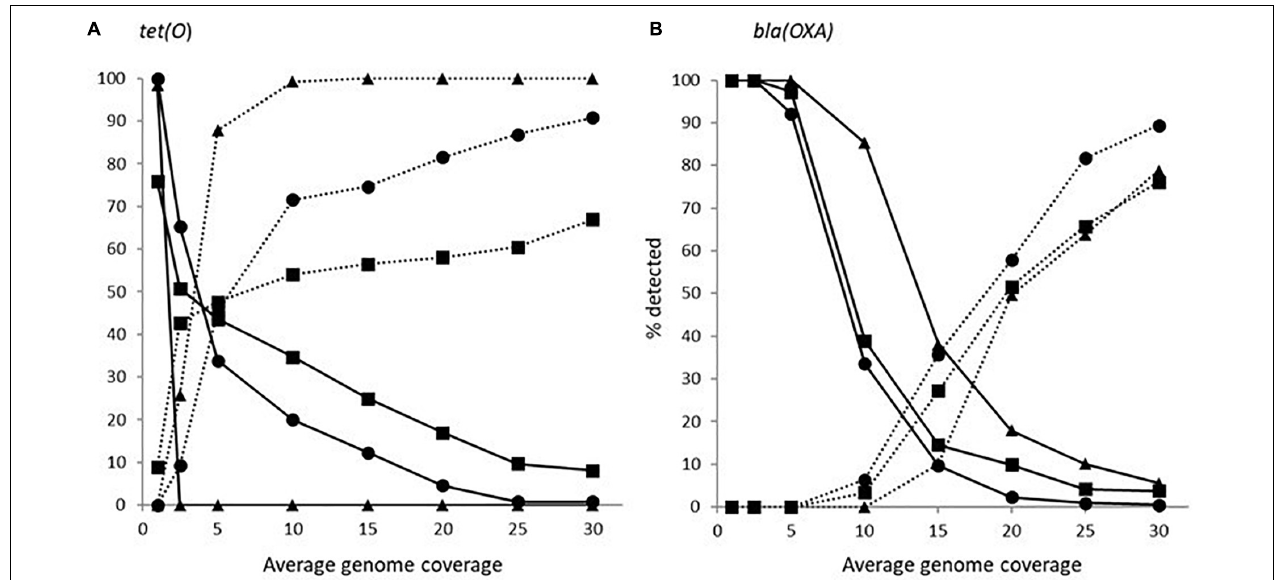
FIGURE 2 | The proportion of Campylobacter isolates found to have a tet(O) (panel A) or a beta-lactamase (panel B) marker that had a < 50% probability of being detected (solid line) and > 90% of being detected (dotted line) using the detection tools KMA ( (cid:4) ), SRTS2 ( • ), and sipprverse ( (cid:78) ) for each level of genome